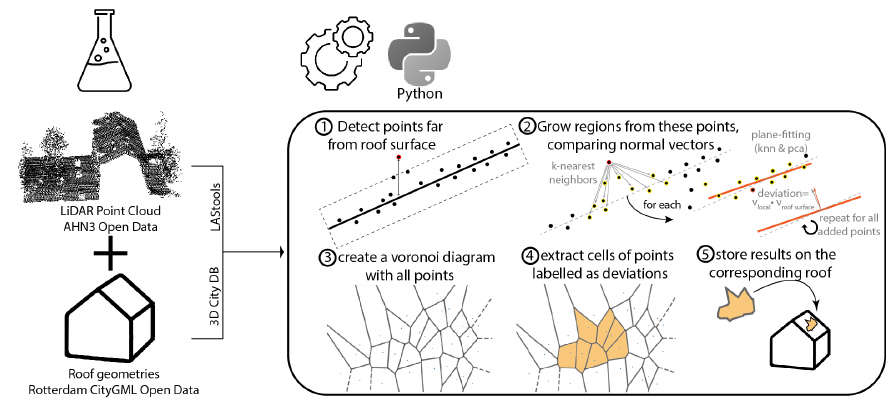
Figure 3. Overview of the method used for semantic enrichment of a 3D city model by using a point cloud